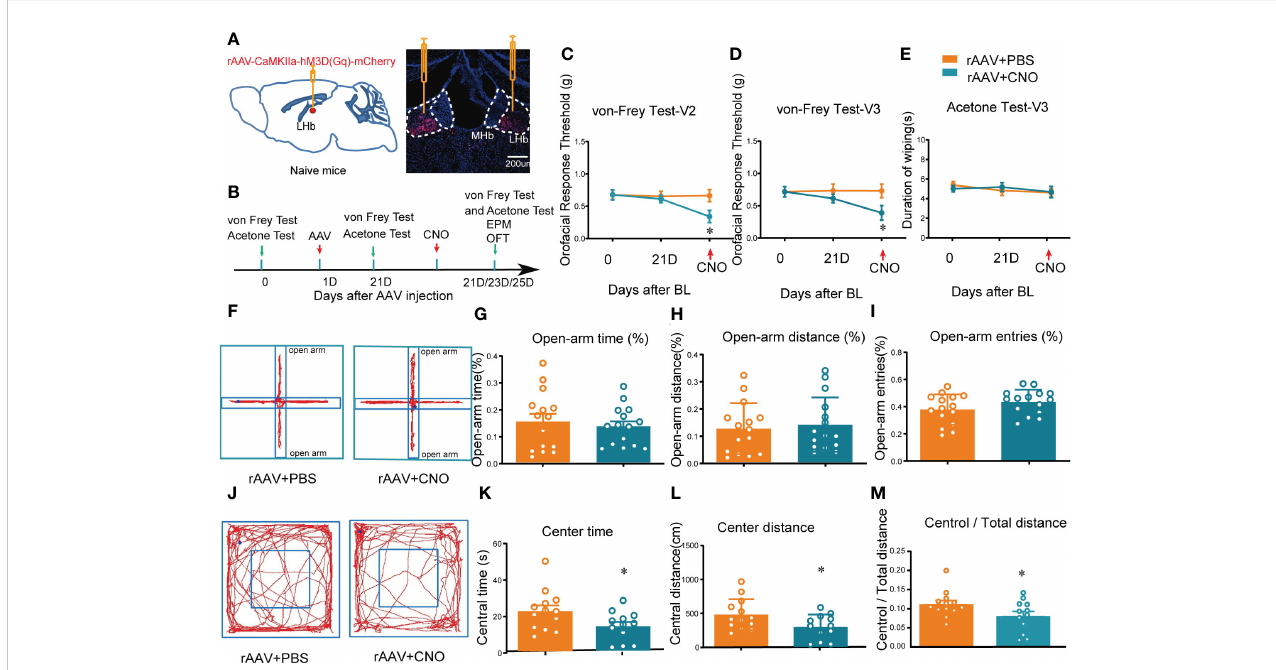
FIGURE 2 Mice showed orofacial allodynia and anxiety-like behaviors after bilateral activation of the LHb. (A) The injection sites of rAAV-CaMKIIa-hM3D(Gq)- mCherry-WPREs-pA virus (left) and typical immuno fl uorescence staining (right). Red, mCherry; Blue, DAPI. (B) The time schedule of behavioral testing, virus injection, and CNO injection. (C, D) Chemogenetic activation of bilateral LHb neurons induced allodynia in the orofacial V2 area (C) and the V3 skin (D) (*p < 0.05 vs. the WT+rAAV+PBS group). (E) Cold allodynia was unchanged in the V3 area as indicated by the lack of statistical differences in the duration of wiping in response to acetone stimulation. (F) Typical trajectory diagram of the EPM test. (G-I) The percentage of time (G) , distance (H) , and entries (I) in the open-arm of the EPM were unchanged by the activation of bilateral LHb neurons. (J) Typical trajectory diagram of the OFT. (K-M) The central time (K) , central distance (L) , and the central/total distance (M) in the OFT were reduced by the activation of bilateral LHb neurons by HM3D(Gq)- CNO (*p < 0.05 vs. the WT+rAAV+PBS